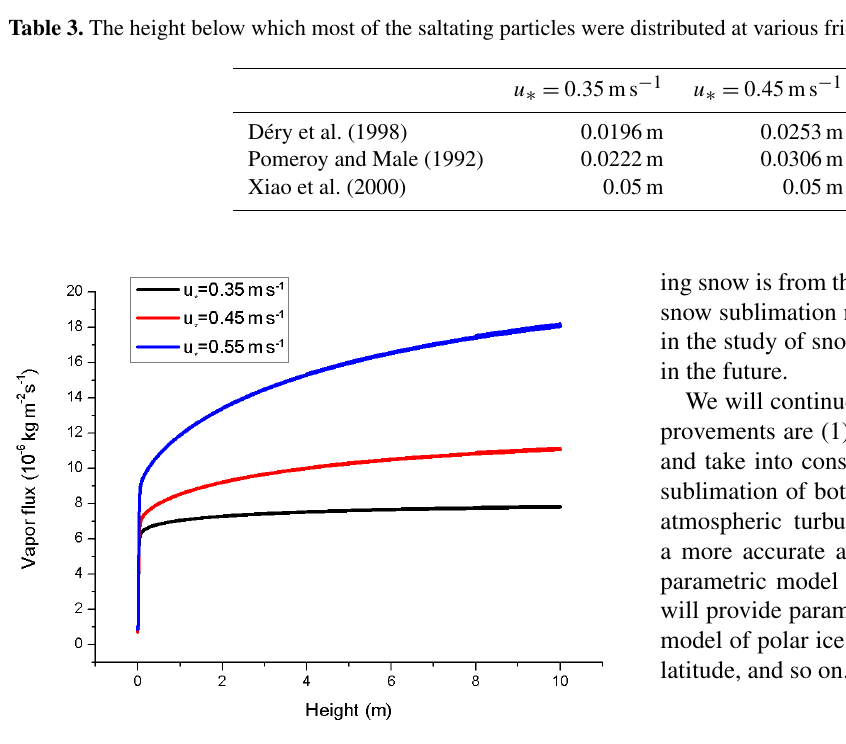
Figure 13. Vertical profiles of vapour